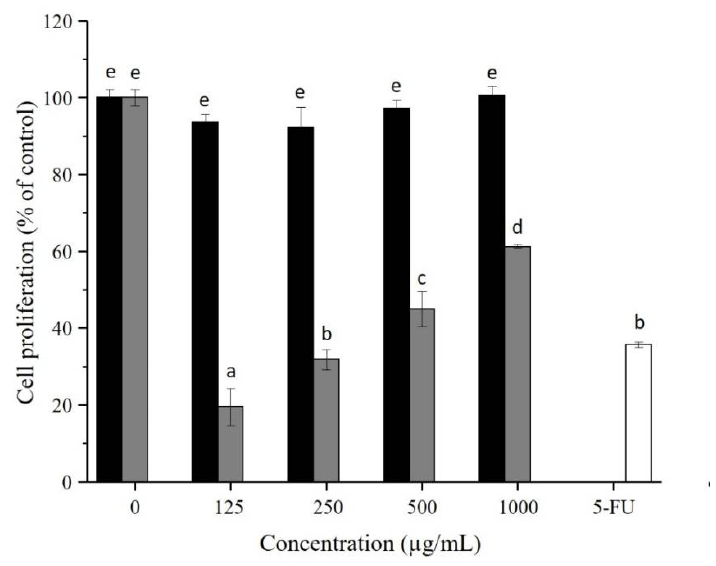
Figure 6. Effect of AX ( (cid:4) ) and AX-f ( (cid:4) ) on the proliferation of Caco-2 cells. 5-FU ( (cid:3) , 26 µ g/mL) was used as positive control. Cells were incubated for 48 h at 37 °C before cell proliferation was measured. Untreated group: concentration = 0. Bars marked by unlike letters are significantly different at p < 0.05, according to a Tukey–Kramer test.